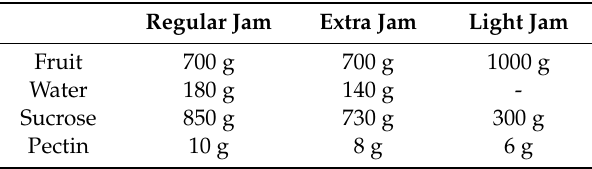
Table 1. Formulations of tart cherry